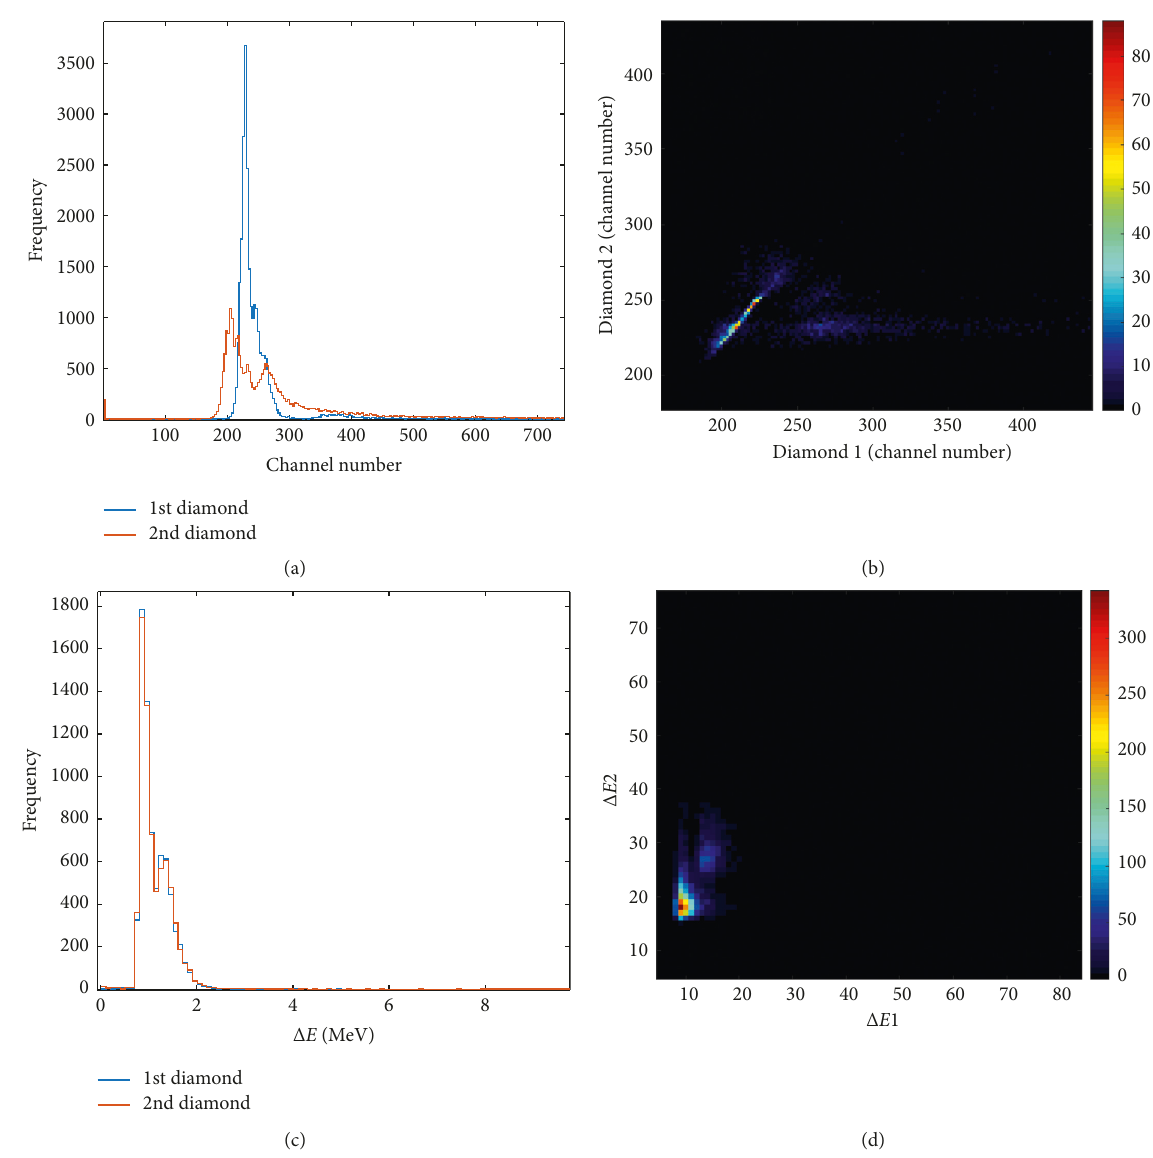
Figure 4: 800MeV proton beam: (a) measured spectra of each diamond, (b) experimental energy depositions in both detectors, (c) Geant4 simulation spectra in the two diamond sensors, and (d) simulated ∆ E 1 versus ∆ E